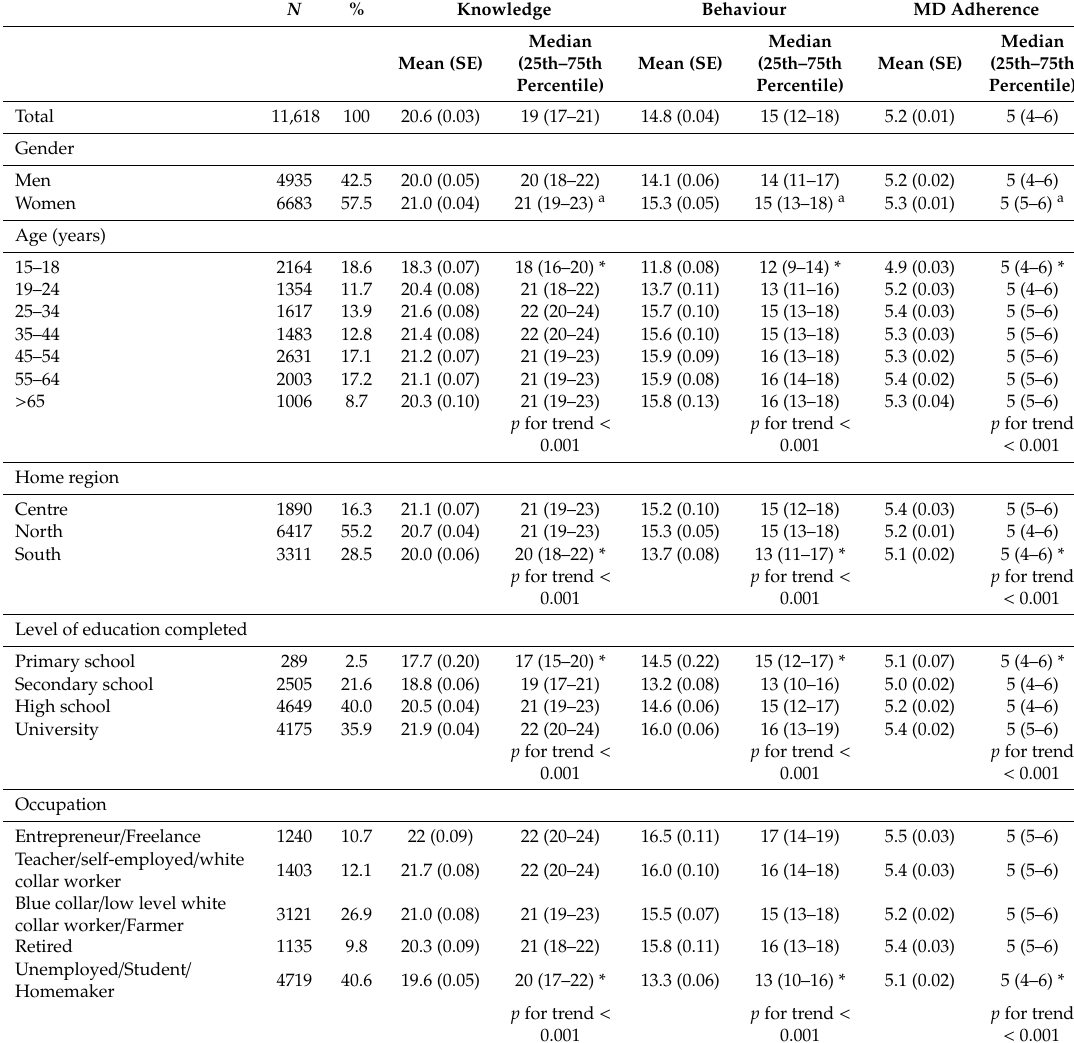
Table 1. Sociodemographic characteristics and mean (standard error) + medians (25th–75th percentile) of knowledge, behaviour and adherence to the Mediterranean Diet (MD) of the study population ( N =